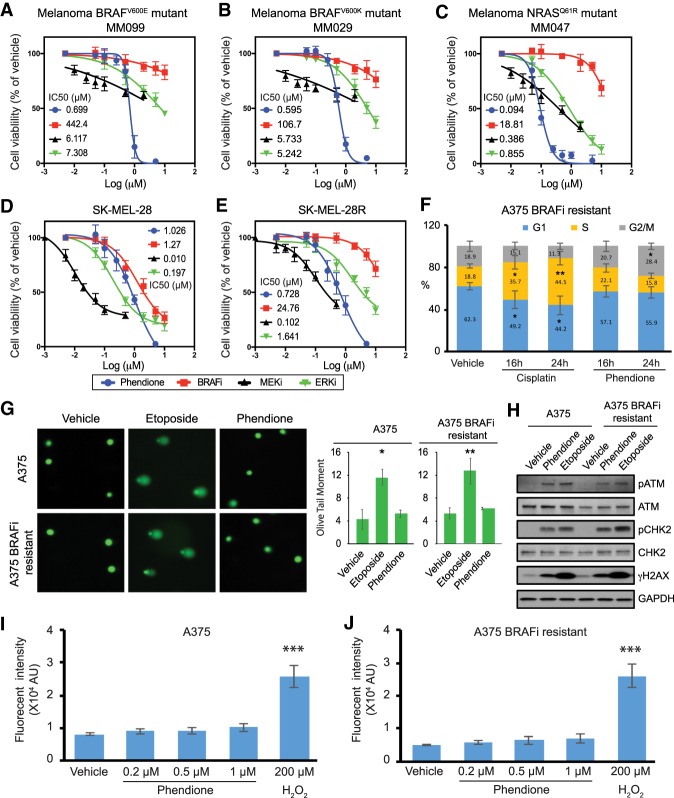
Phendione inhibits the proliferation of melanoma with intrinsic resistance to MAPK inhibitors. (A–E) Panels show growth inhibition curves and IC50 values. Primary patient-derived melanoma cell lines with BRAFV600E, BRAFV600K, and NRASQ61R mutations (A–C), and human melanoma cell line SK-MEL28 (D) and its BRAF inhibitor (dabrafenib)-resistant line SK-MEL28R (E) were treated with phendione or inhibitors of the MAPK pathway for 96 h. Data are presented as mean ± SD of three independent experiments. (F) Cell cycle analysis for A375 BRAFi-resistant cells. Cells were treated with 2.5 µM cisplatin, 0.2 µM phendione, or vehicle for the indicated time. Graph shows the percentage of cells in each phase of the cell cycle. Data shown are average ± SD of three independent experiments. (G) Comet assay to measure DNA damage. Representative images are shown at the left and quantification results are shown at the right. Data are presented as mean ± SD of three independent experiments. (H) Immunoblots of whole-cell lysate collected from comet assay. (I,J) Quantification of reactive oxygen species (ROS) production measured by flow cytometry in A375 (I) and A375 BRAFi-resistant (J) cells. Hydroxyl peroxide (H2O2; 200 µM) was used as positive control. Data are presented as means ± SEMs of three independent experiments. (*) P < 0.05; (**) P < 0.01; (***) P < 0.001. Statistical analysis was performed using unpaired two-tailed Student's t-test.